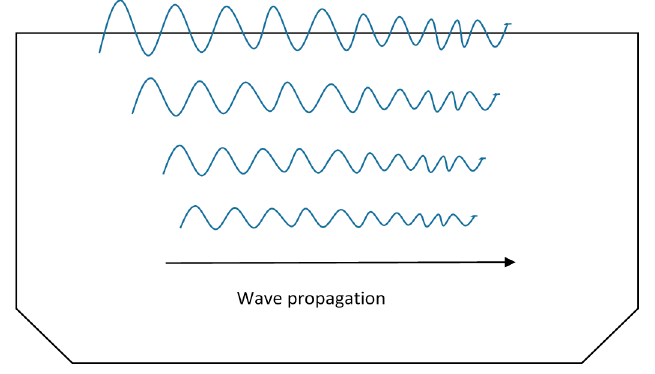
Figure 4. Rayleigh waves propagation (adapted from [10]).